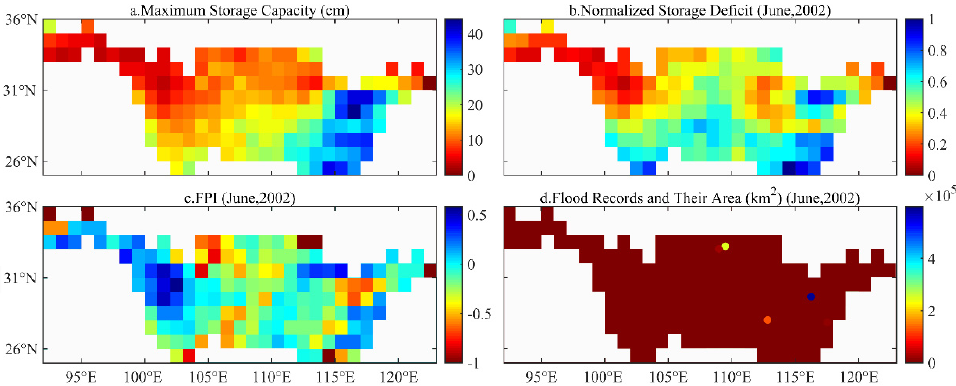
Figure 4. Examples involved in calculating the FPI in the YRB during April 2002–December 2019. (( a – d ) are the MSC (cm), normalized storage deficit in June 2002, FPI in June 2002, and flood records and their area (km 2 ) in June 2002,